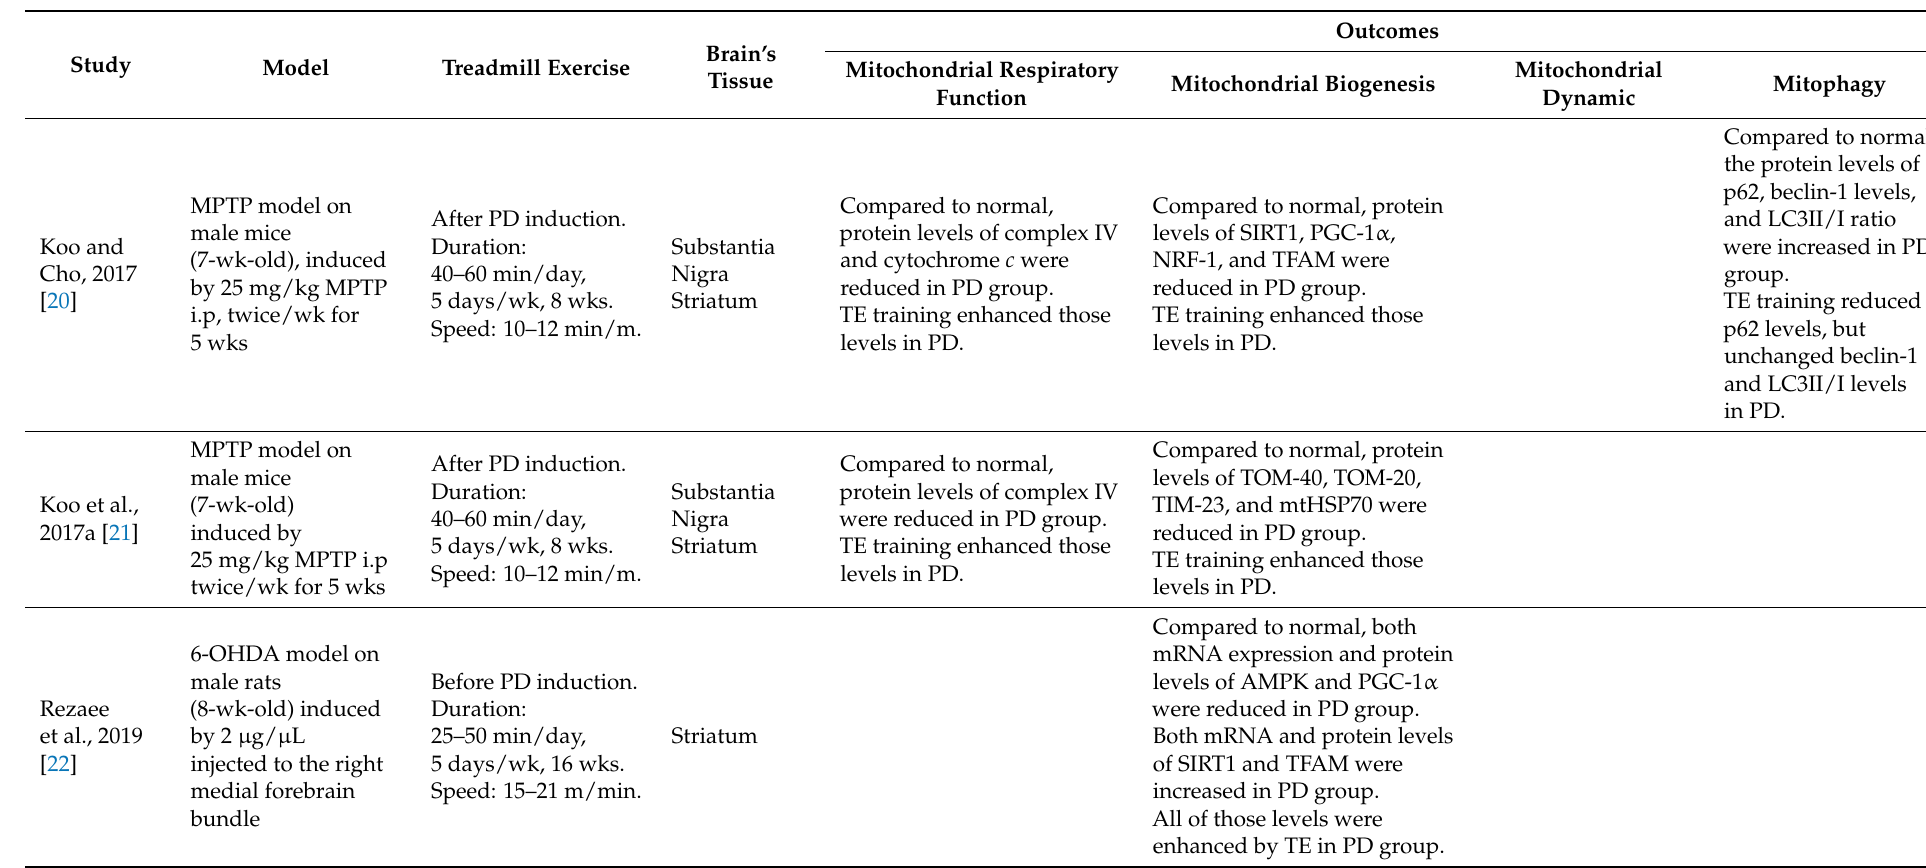
Table 1. Characteristics and outcomes of the included